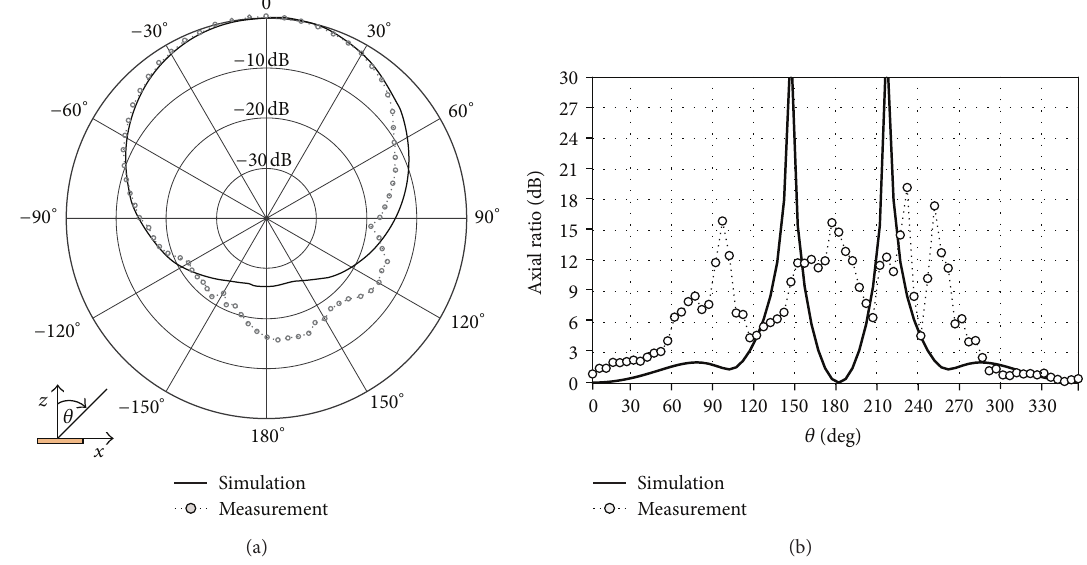
Figure 10: The measured radiation pattern and axial ratio of the circular microstrip antenna with the AMC model-O. (a) Radiation pattern. (b) Axial ratio.